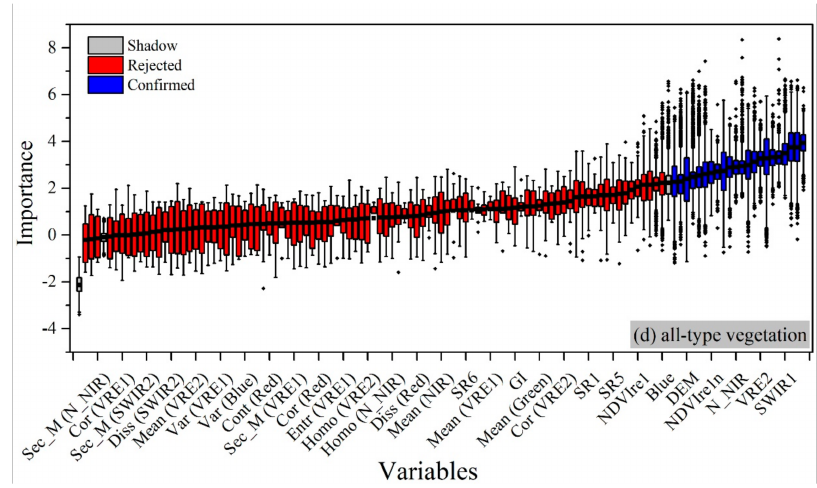
Figure 4. Importance of candidate variables: ( a ) low vegetation; ( b ) broadleaved forest; ( c ) coniferous forest; and ( d ) all-type vegetation. Important variables are labeled as Confirmed in blue, unimportant ones as Rejected in red, and shadow ones as Shadow in grey.